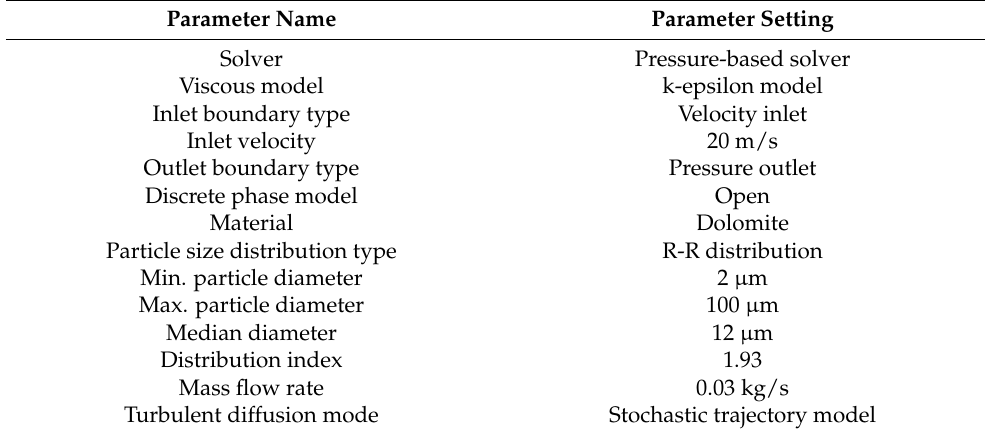
Table 1. Calculation model